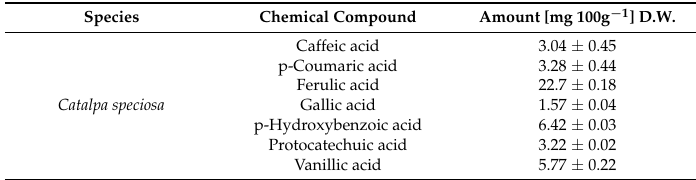
Table 1. The phenolic acid compositions of Catalpa speciosa , Taxus cuspidata , and Magnolia acuminnata outer bark